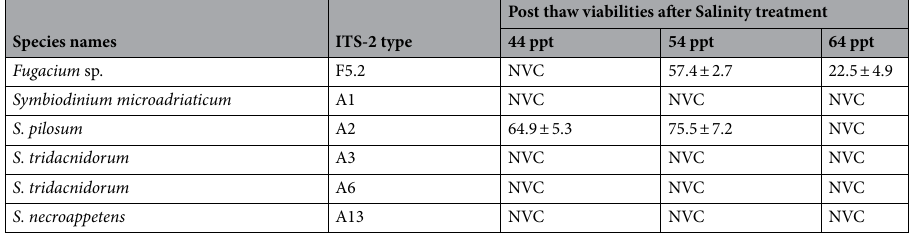
Table 4. Cell viabilities after rapid freezing with salinity treated culture isolates using 15% dimethyl sulfoxide (DMSO) as the cryoprotectant agent (CPA). Values are mean percentage of three replicates (n = 3) ± standard deviation (SD) of the mean. NVC no viable cells